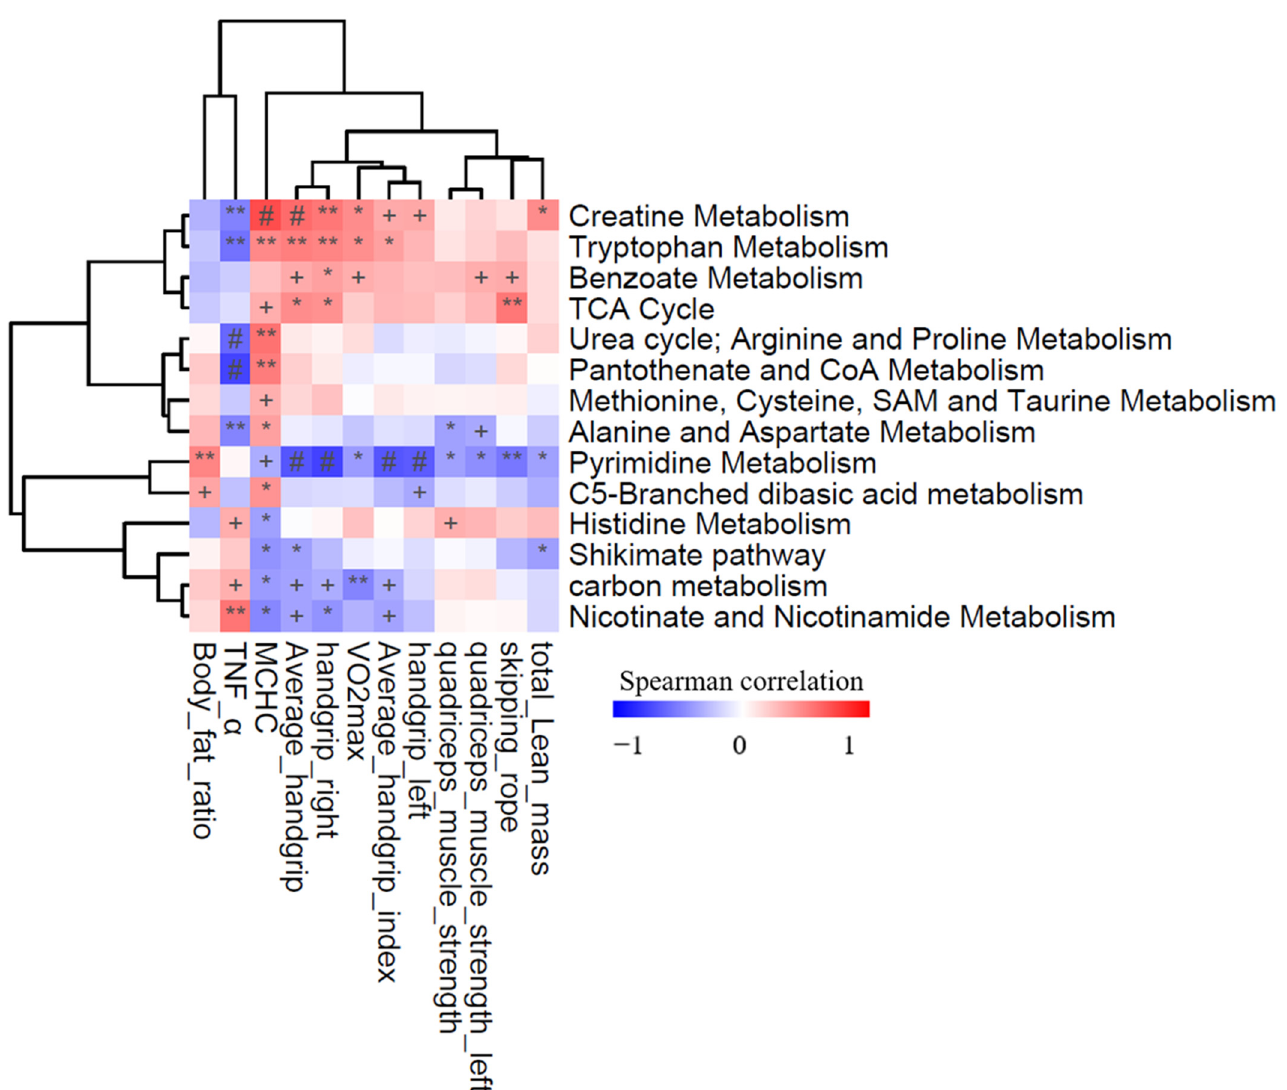
Figure 4. Correlation of β -glucan supplementation with athletic performance. Relationships between phenotypes and the concentration of metabolism pathways. The heatmap displays the Spearman correlation coefficients between phenotypes and metabolism pathways. The significance levels in the correlation tests are denoted as: + p < 0.1; * p < 0.05; ** p < 0.01; # p < 0.001. Details of correlation were shown in Supplementary Figure S1.